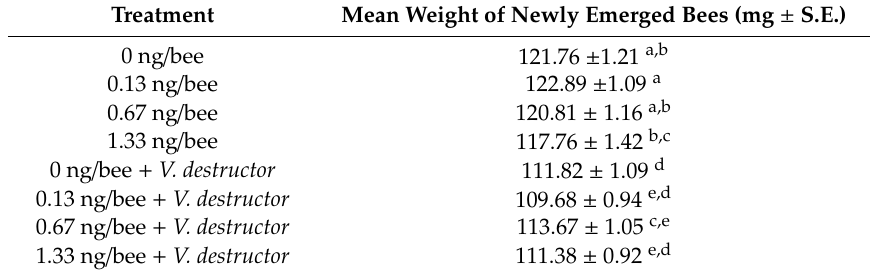
Table 2. Mean weight of newly emerged bees ( ± S.E.) exposed to sublethal doses of clothianidin (ng / bee) and / or V. destructor during the larval